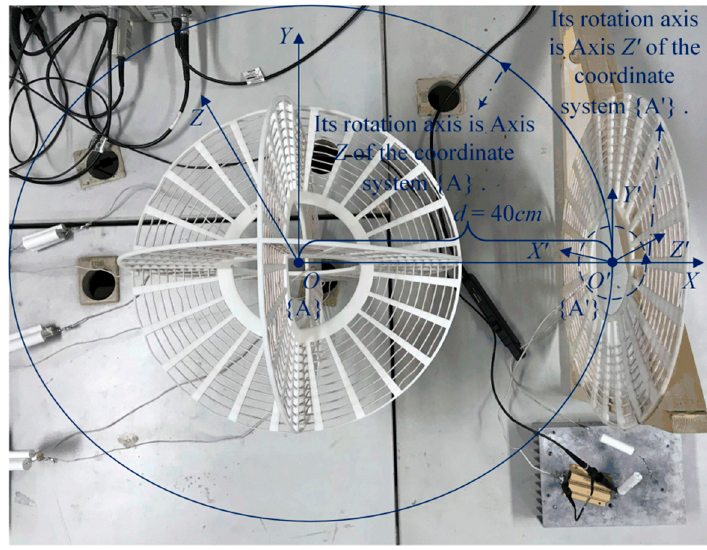
Figure 13. The schematic diagram of experimental condition. Table 5. Parameters of the coils obtained from ZX8526A at 200